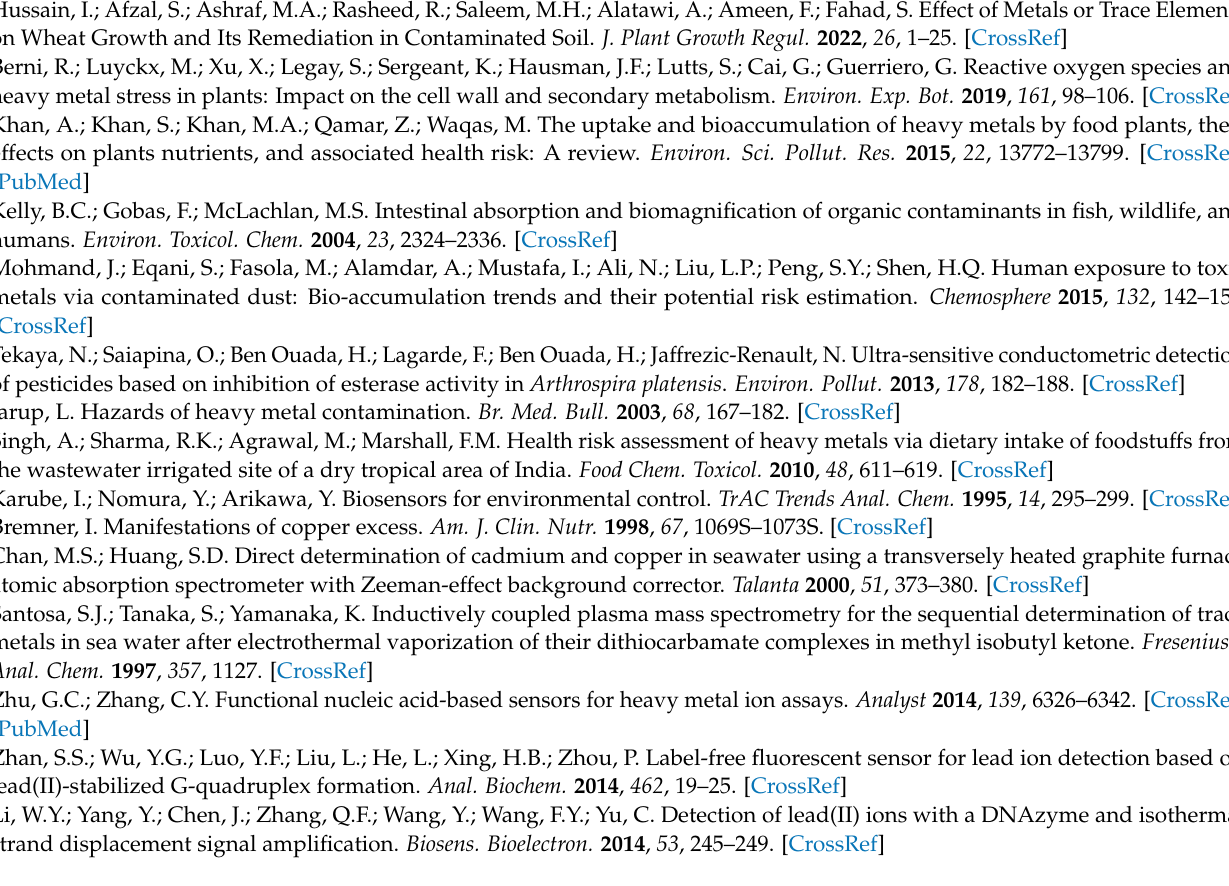
of H 2 O 2 (Figure 2E Original data); Table S4: Absorbance: Optimization of the ratio of Cu–Enz and Cu– Su (Figure 2F Original data); Table S5: Absorbance ( λ = 419 nm) under different Cu 2+ concentrations (Figure 3B,C Original data); Table S6: Absorbance: The change of absorbance ( ∆ Abs) of the turn-off sensor after adding different metal ions (Figure 4A Original data); Table S7: Determination of Cu 2+ in four different water samples using the biosensor and ICP-MS (Table 2 Original data); Figure S1: The original size of Scheme 1A; Figure S2: The original size of Scheme 1B; Figure S3: The original size of Scheme